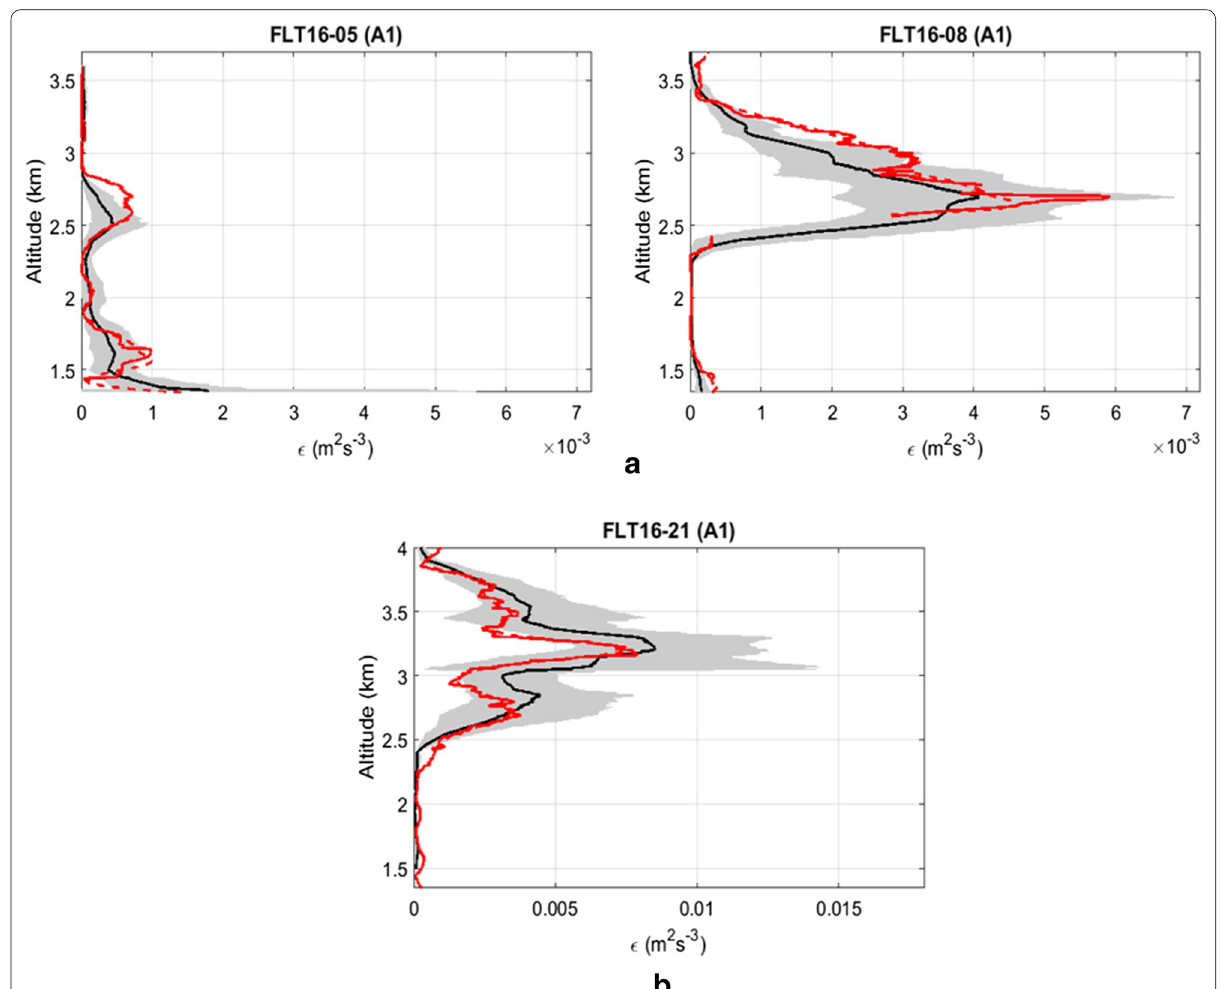
Fig. 8 a Comparisons of smoothed profiles of ε U (red solid and dashed lines) and ε R (solid line) for FLT16-05 (A1) (left) and FLT16-08 (right). The gray areas show the mean rms values of ε U for the 4 min of time averaging. b Same as a but or FLT16-21 ±